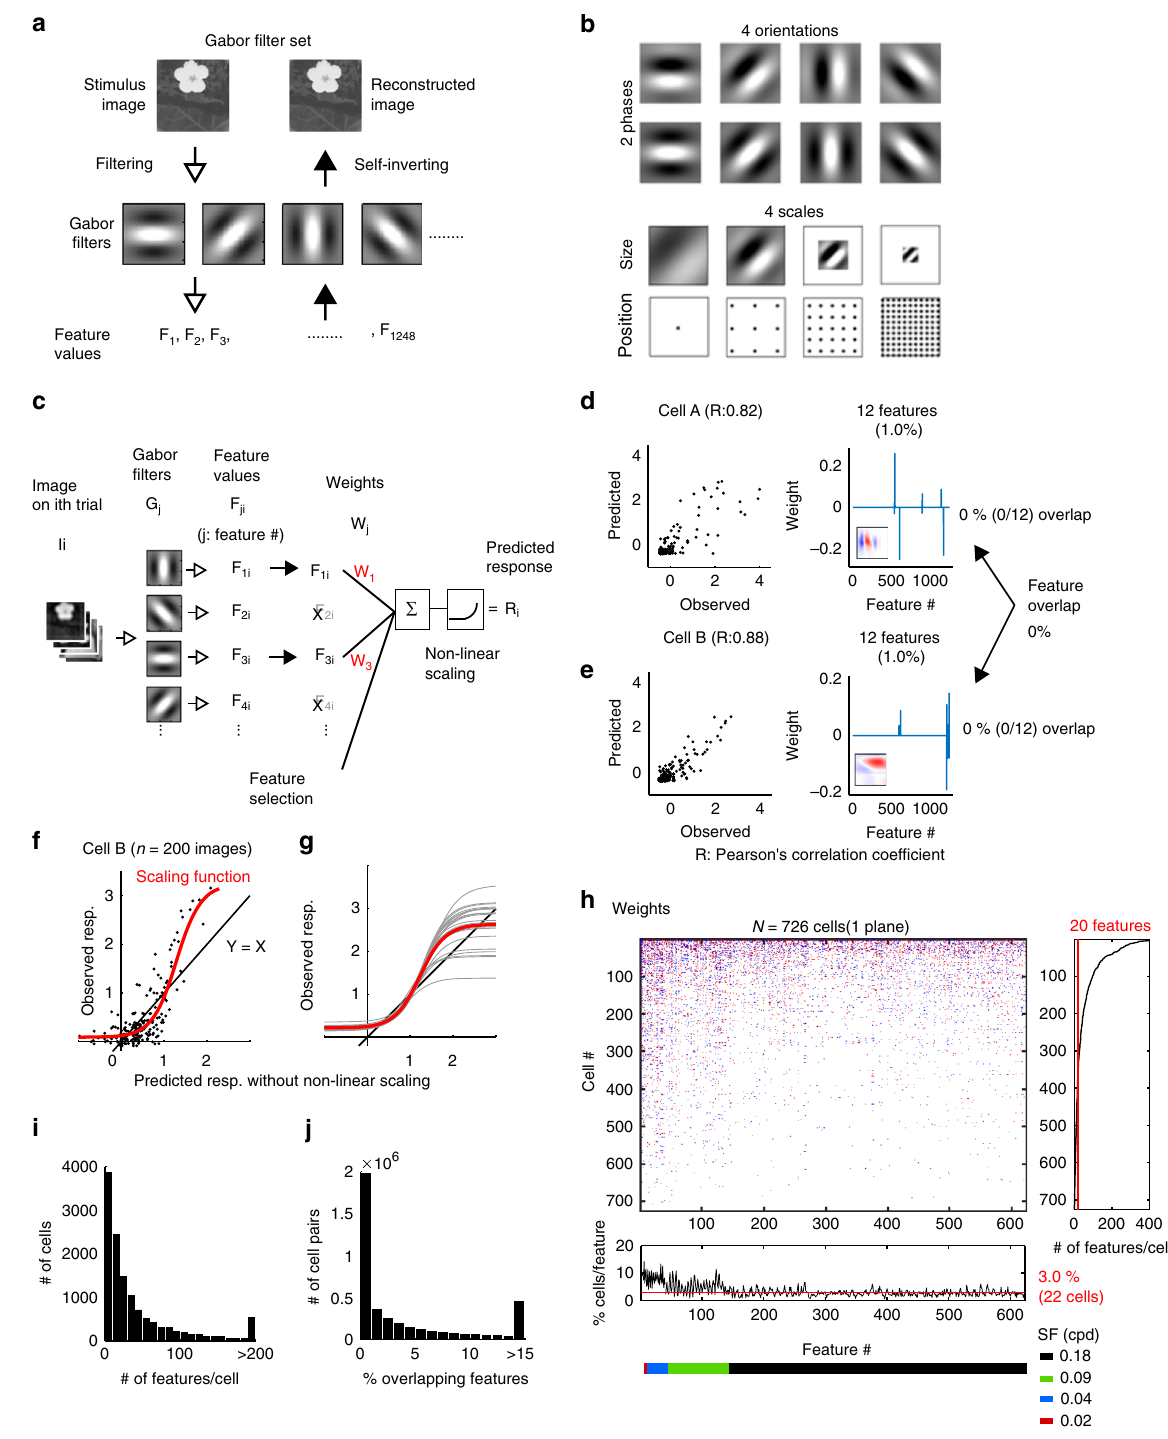
In example neurons (Fig. 2d, e), the response prediction performances (the correlation coef fi cients between the observed and the predicted responses) were 0.82 and 0.88. These neurons were represented by 12 (out of 1248) Gabor features (Fig. 2d, e, right panels). We de fi ned a forward fi lter as a weighted sum of the Gabor fi lters; the forward fi lters of the example neurons were spatially localized (Fig. 2d, e, insets in the right panels). The median prediction performance of the encoding model was 0.32 (0.15 – 0.50) in the example plane presented in Fig. 1 (median (25 – 75th percentiles); n = 726 cells) and 0.21